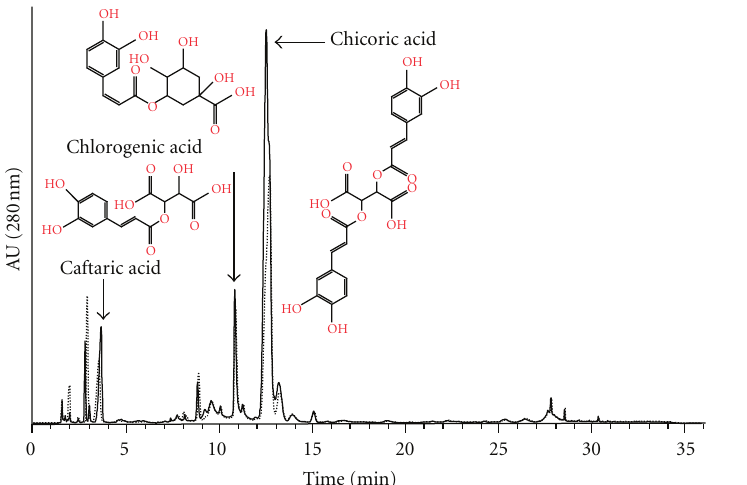
Figure 1: Chromatographic profiles of chicory leaves at 280 nm. Dotted line and continuous line represent HPLC profiles obtained for the same fresh leaf tissue area with a “conventional” liquid nitrogen grinding and the “novel” method, respectively.